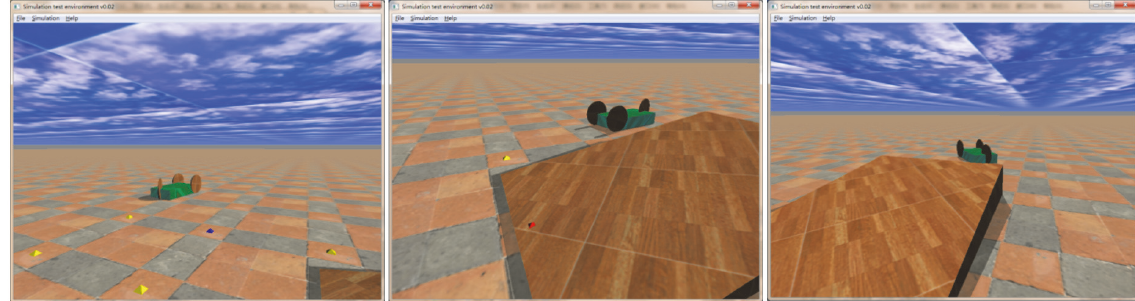
Figure 5: The vehicle model has high-speed collision with obstacle and rollover, due to high-speed turning and rushing out of the ramp.